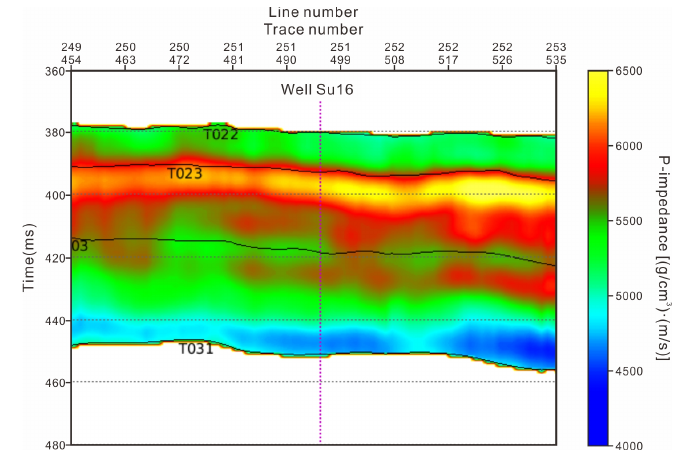
Figure 5. The result of deterministic inversion around Well